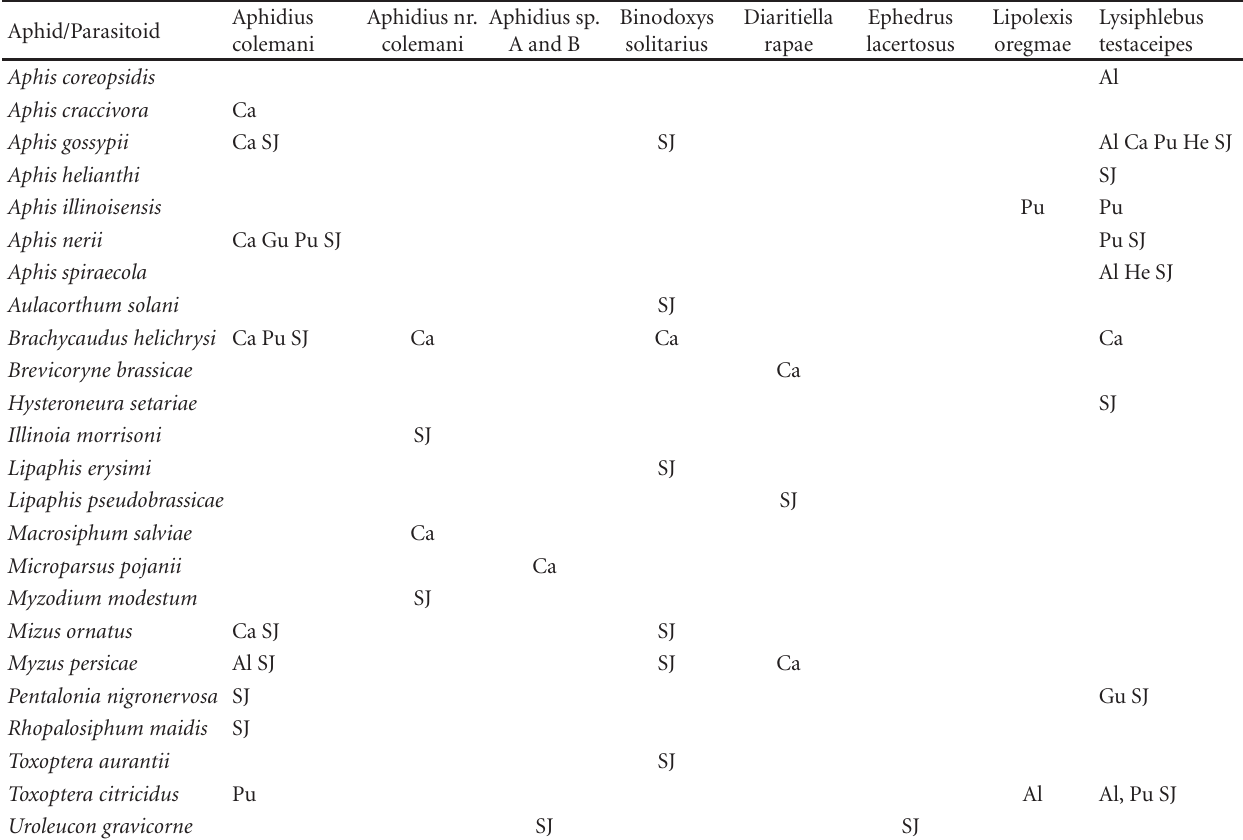
Table 1: Aphid-Aphidiinae associations in Costa Rica. Note that the record of Binodoxys solitarius from Aulacorthum solani is actually an undetermined species of Binodoxys (see text). Letters refer to provinces shown in map (Figure 1): Al = Alajuela, Ca = Cartago, Gu = Guanacaste, He = Heredia, Pu = Puntarenas, SJ = San Jos´e. Aphidius Aphidius nr. Aphidius sp. Diaritiella Lipolexis Aphid/Parasitoid colemani colemani solitarius lacertosus oregmae Aphis